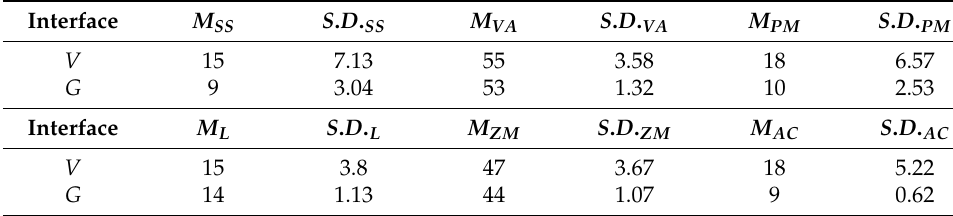
Table 8. Mean driving penalty points ( M ) and standard deviations ( S . D .).